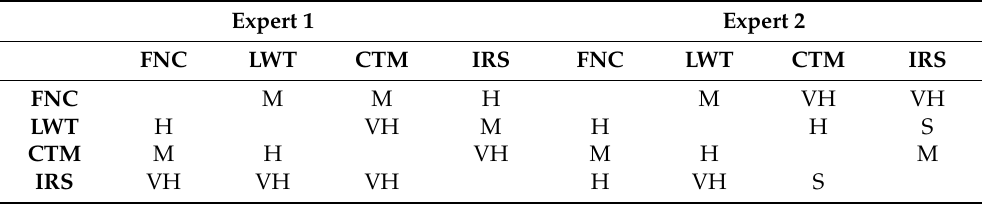
Table A8. Linguistic evaluations of experts for the